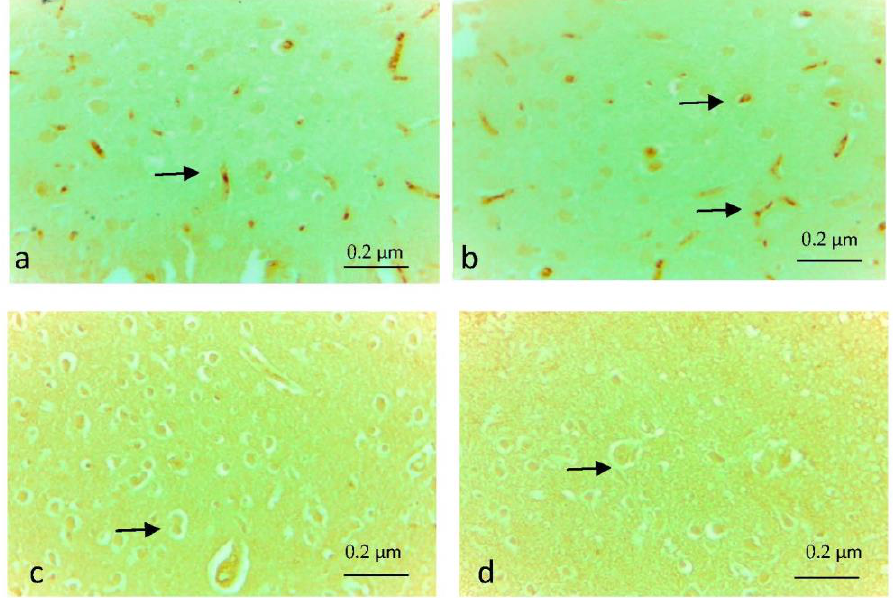
Figure 3. ( a , b ) tnf- α immune positive cells (arrows) in the electric field group, × 40; ( c ) Tnf- α immune negative cells (arrow) in the electric field + Juglone group, × 40; ( d ) Tnf- α immune negative cells (arrow) in the Control group, ×40.